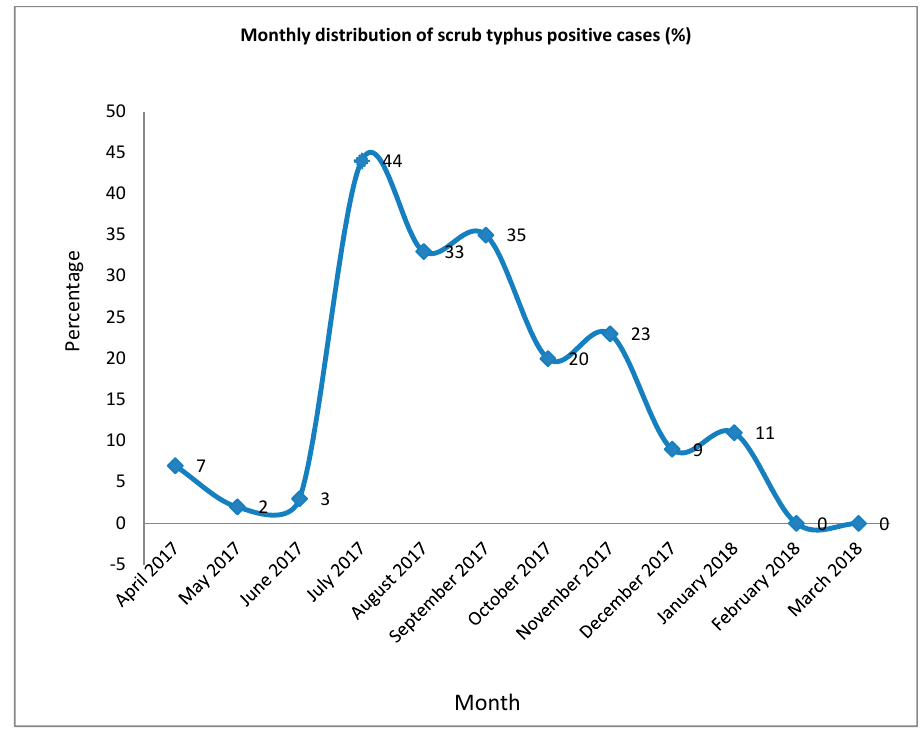
Figure 1. Monthly distribution of scrub typhus positive cases (percentage of total) indicating the highest percentage of positive cases in the month of July.